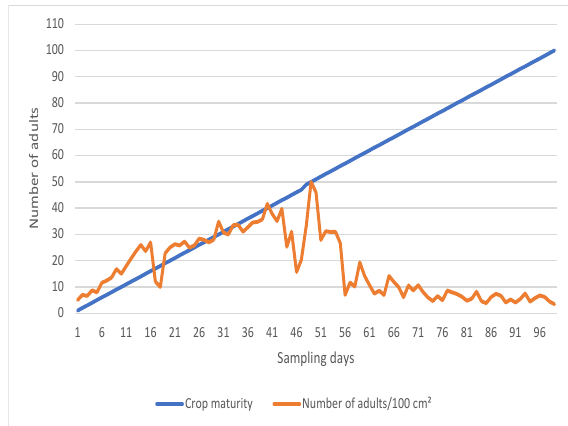
Figure 14. Number of Prodiplosis longifila adults per 100 cm 2 in light traps with sticky surface panel throughout the crop